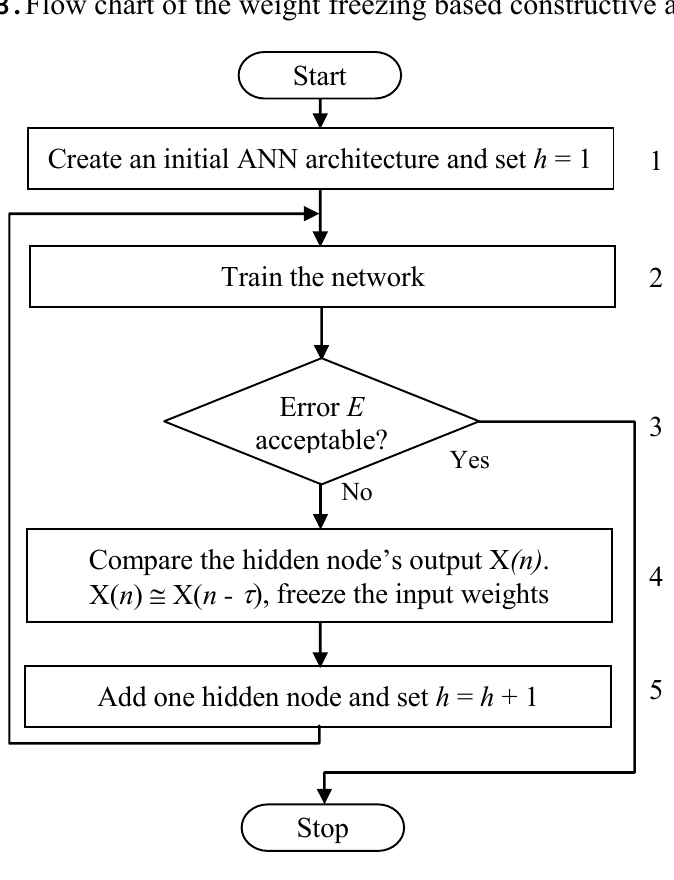
Figure 3. Flow chart of the weight freezing based constructive